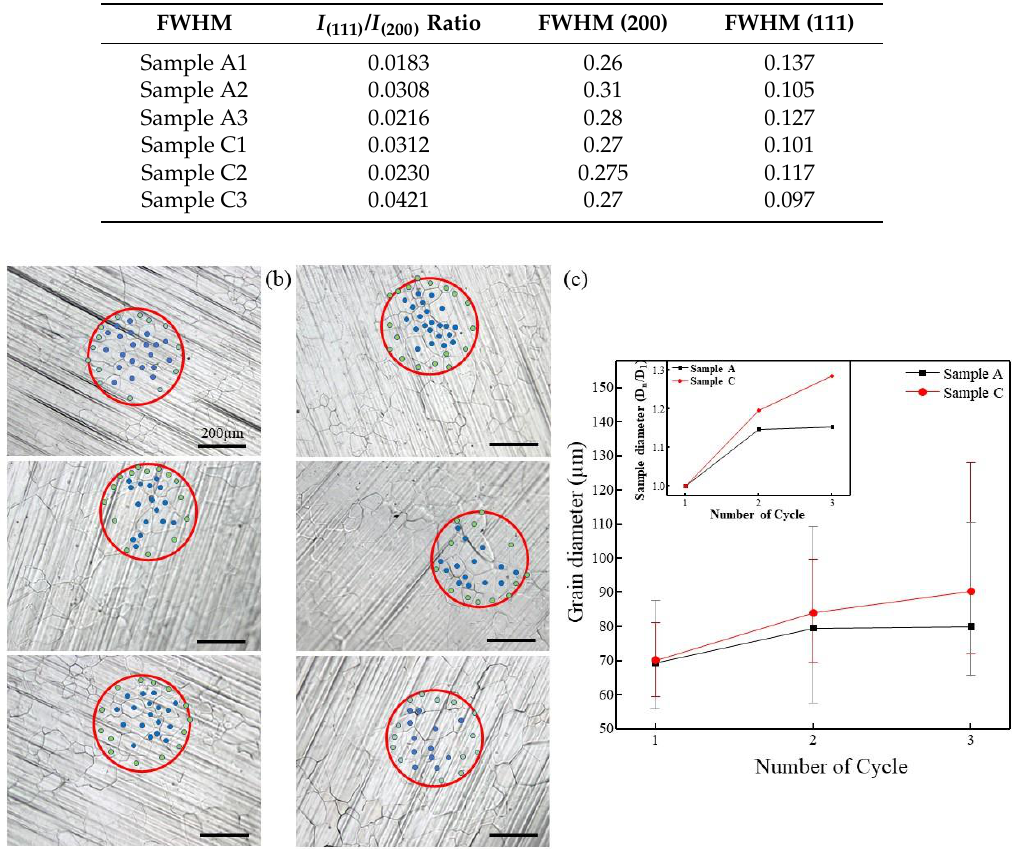
Figure 3. LM images of ( a ) Sample A, and ( b ) Sample C. A blue dot represents a grain in the red circle, and a green dot represents a grain that spans the red circle. ( c ) Calculated grain area after each CVD cycle.